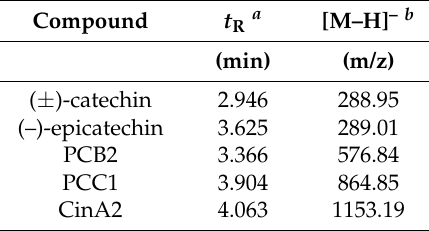
Table 1. MS settings for individual polyphenol analysis by reverse-phase (RP)-UPLC-MS.